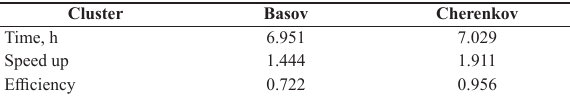
Table 6. ODETTA implementation using one node with two